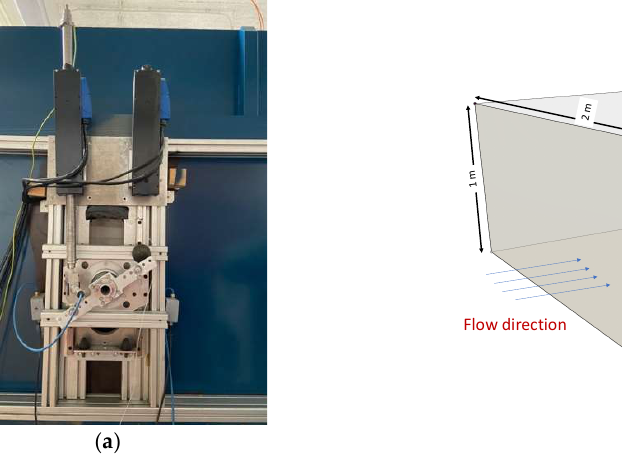
Figure 2. Schematic representation of the position control mechanism attached to the wind